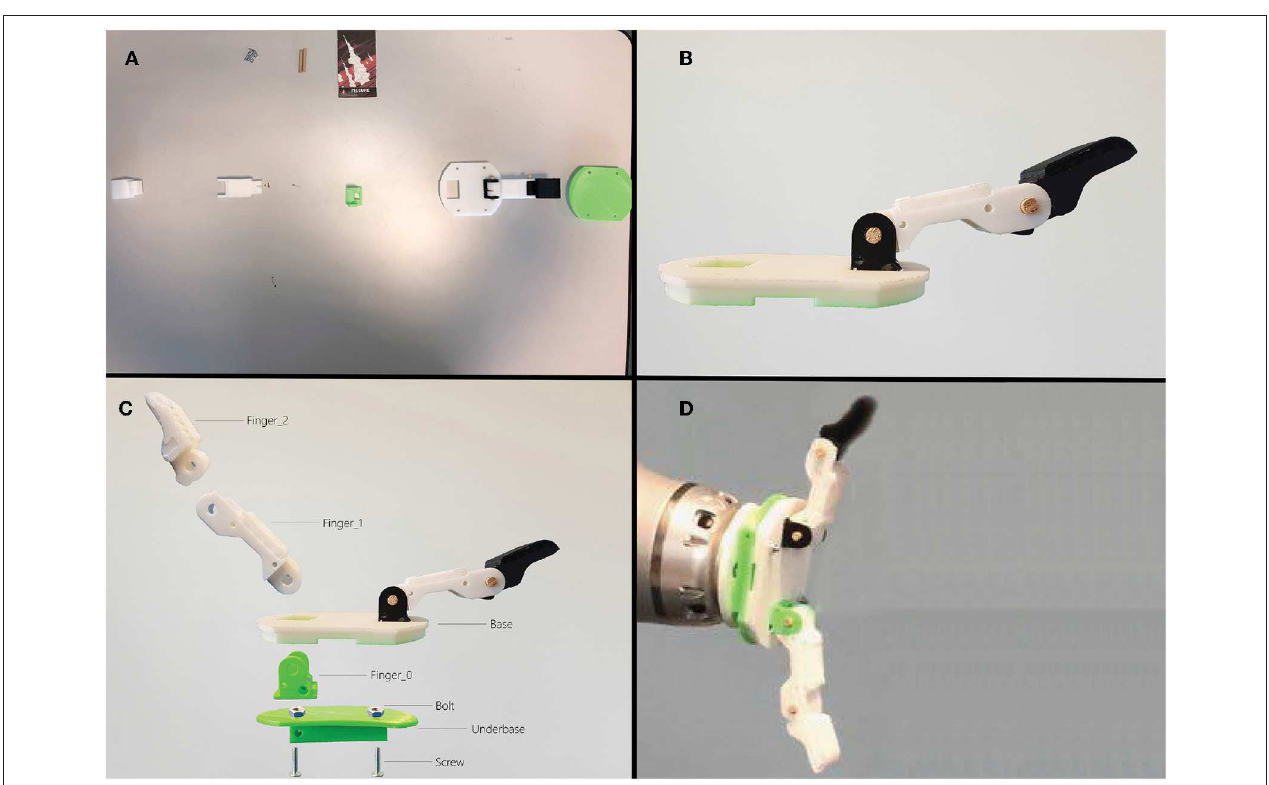
FIGURE 7 | Top-left image (A) : the initial configuration. Top-right image (B) : the finger already assembled. Bottom-left image (C) : the renamed hand pieces. Bottom-right image (D) : the complete hand placed at the end-effector position.